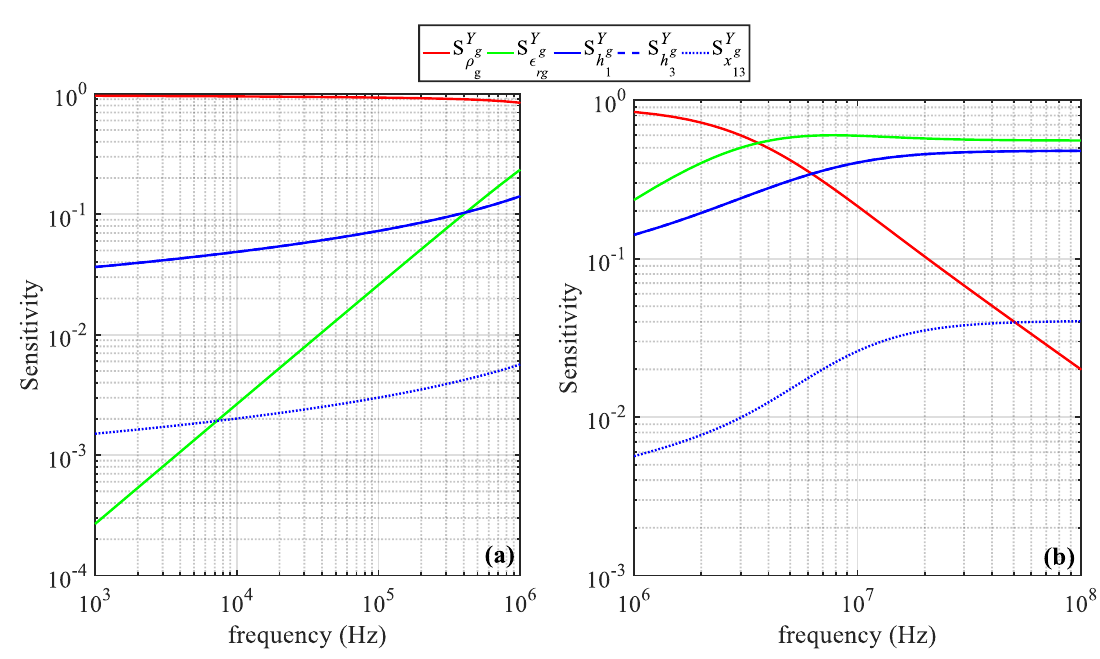
Figure 4. Normalized sensitivities of the mutual admittance for ( a ) NB and ( b ) BB.